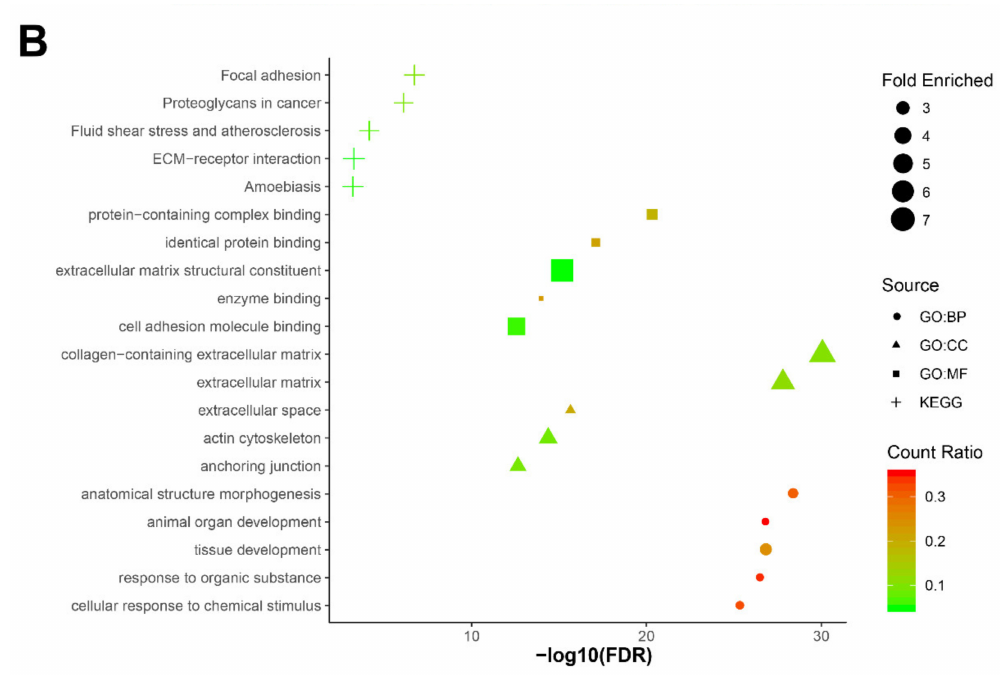
Figure 4. Weighted gene co-expression network analysis (WGCNA) of 72 pancreatic CTCs. ( A ) The cluster dendrogram of 3000 genes, five modules (blue, brown, green, turquoise, and yellow), were identified. The brown module correlates with the stem trait most significantly ( r = 0.95, adjusted p -value = 3.6 × 10 − 3 ). ( B ) The functional enrichment analysis of genes in the brown module (generated by imageGP, available online: http: // www.ehbio.com / ImageGP / index.php / Home / Index / index.html, accessed on 23 April 2020), top 5 enriched Kyoto Encyclopedia of Genes and Genomes (KEGG) pathways, Gene Ontology (GO) terms for biological processes (BP), cell components (CC) and molecular functions (MF) are shown [fold enriched > 2 and false discovery rate (FDR) < 0.010].